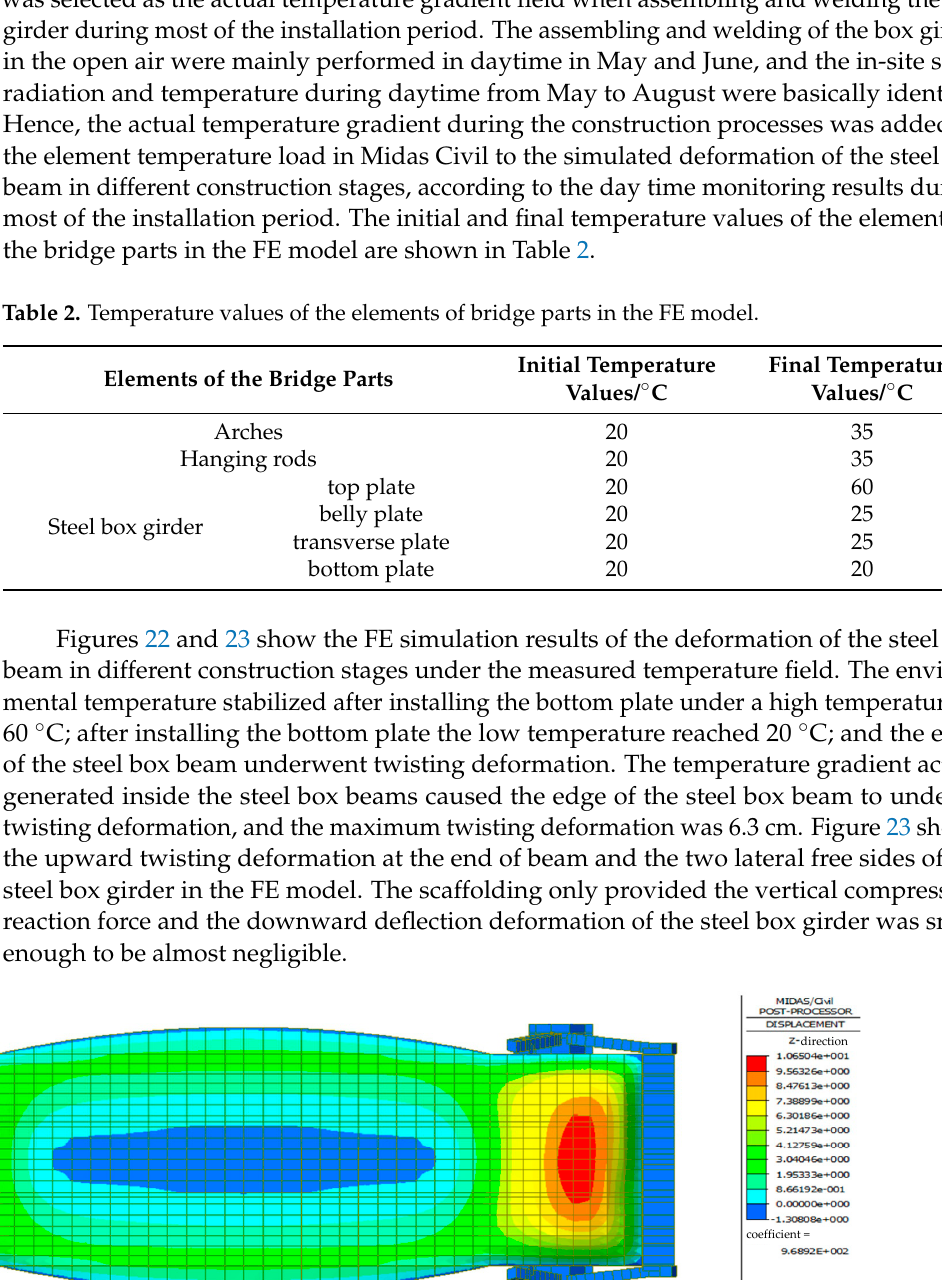
Figure 22. Deformation of the box girder after installation of the bottom plate (unit: mm).